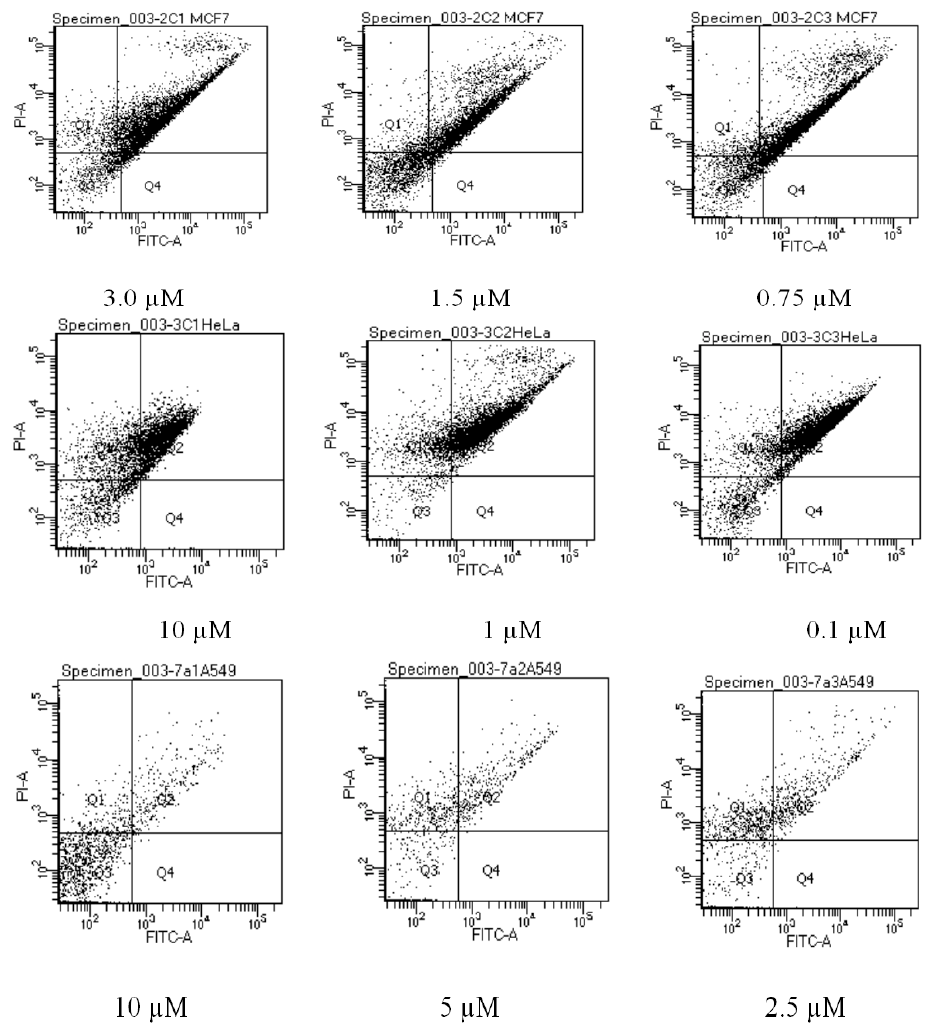
Figure 3. Effects of compound 2c , 3c , and 7a on the induction of apoptosis in MCF-7, HeLa and A549 cells stained with Annexin V-FITC and propidium iodide (PI), respectively.